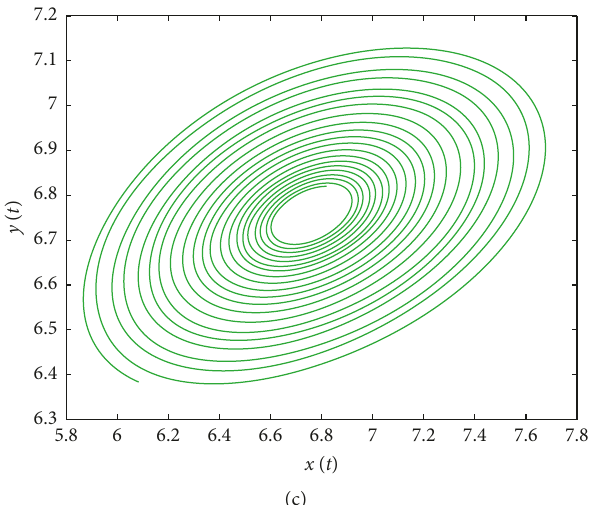
Figure 8: The time series and portrait phase of model (71) when u < Kr /4, here α � 0 . 3 ,K � 8 ,r � 2 and u � 2 . 1. (a) The time series of x ( t ) ; (b) the time series of y ( t ) ; (c) the portrait phase.